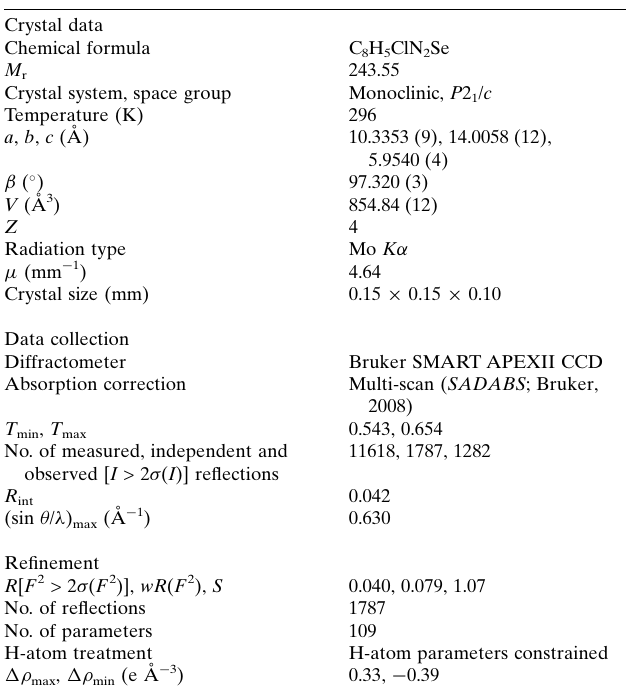
Table 2 Experimental details.